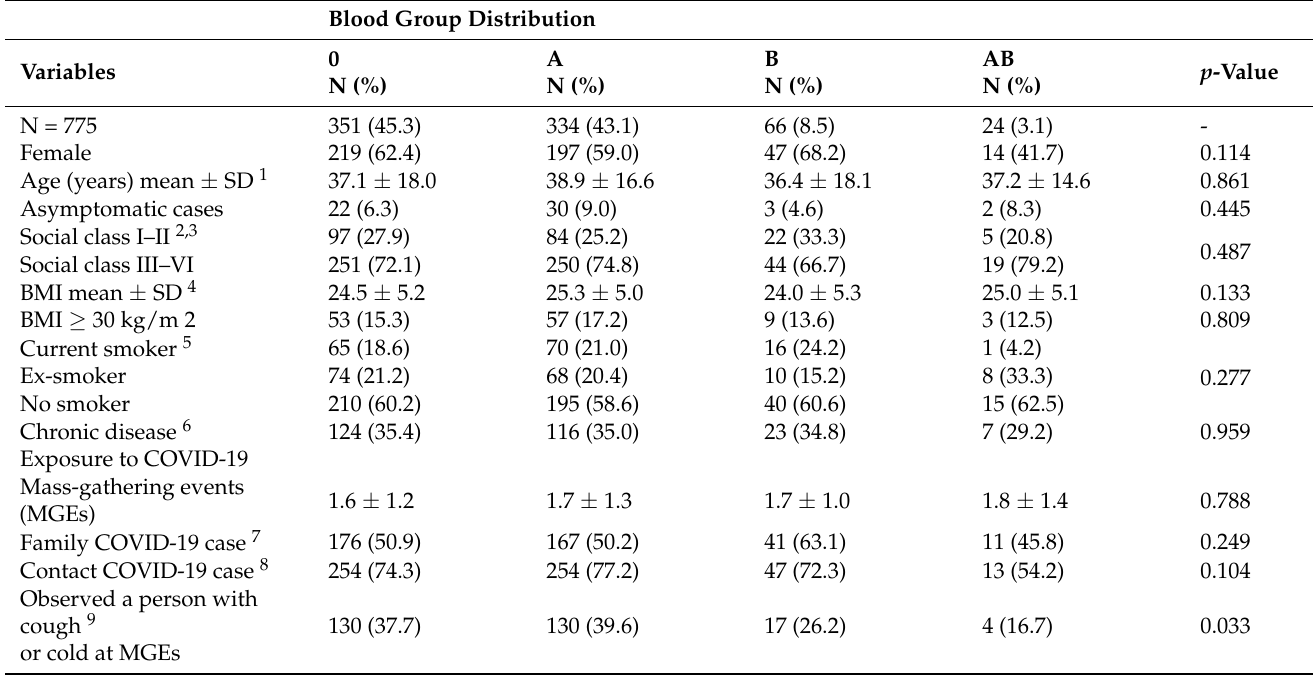
Table 1. Characteristics of ABO blood groups. Borriana COVID-19 cohort, 2020. Blood Group